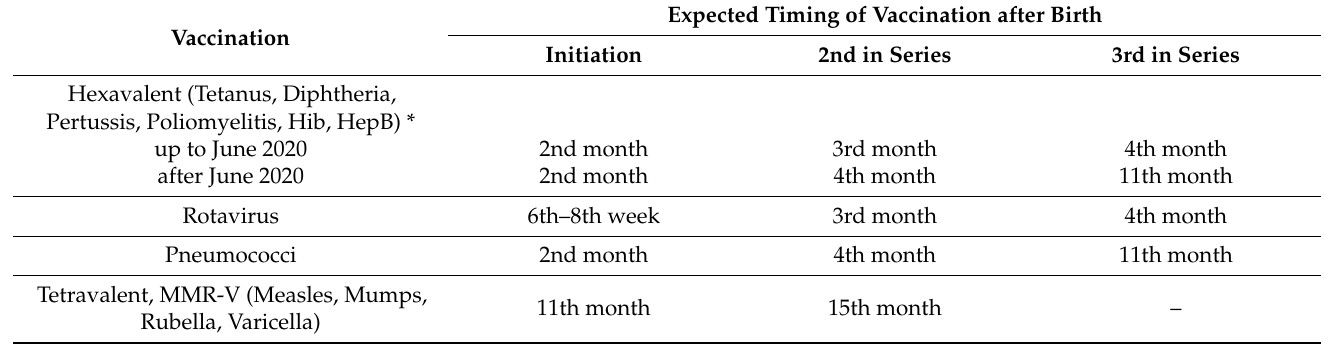
Table 2. Summary of vaccinations recommended for children in the first 18 months of a child’s life and details of the number and timing of doses